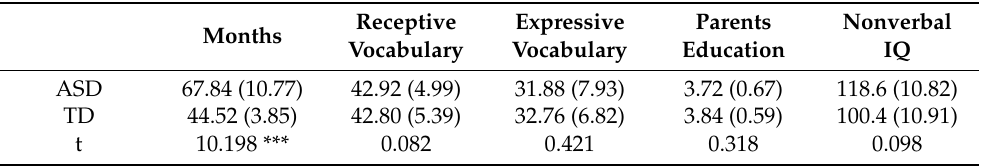
Table 1. Characteristics of ASD ( n = 25) and TD ( n = 25)